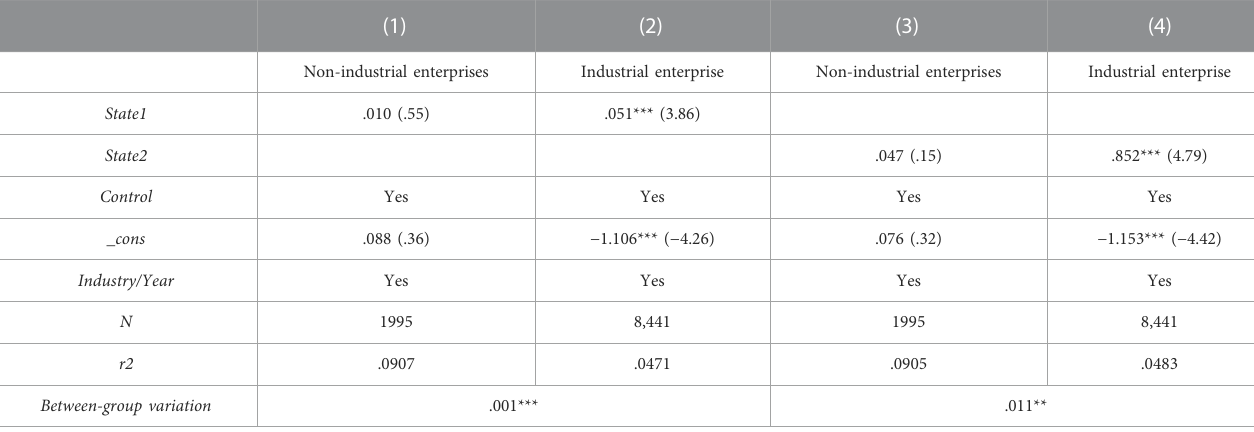
TABLE 5 Group test of the industry heterogeneity of private